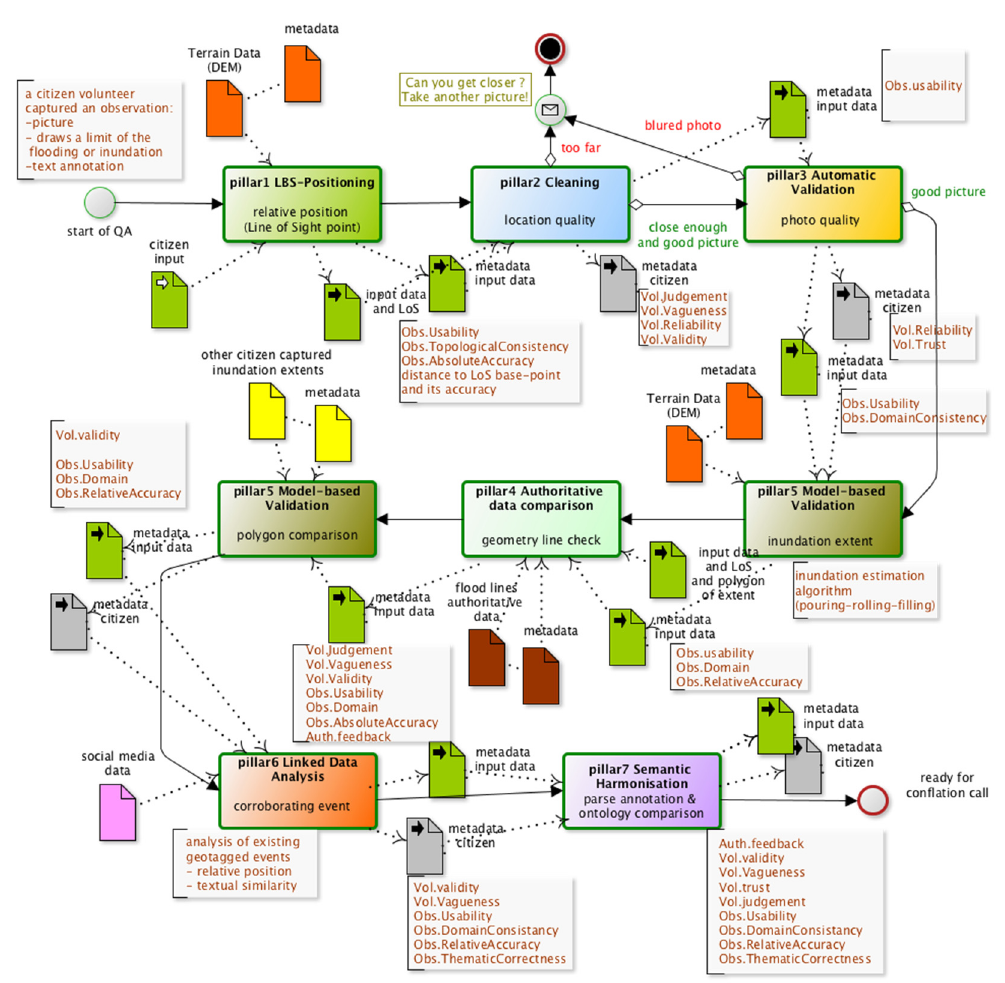
Figure 3. Example of a quality assurance (QA) workflow for flooding/inundation in COBWEB. Business Process Modelling Notation (BPMN) workflow with annotations of quality elements generated for the User, the Observation, or the Authoritative data.